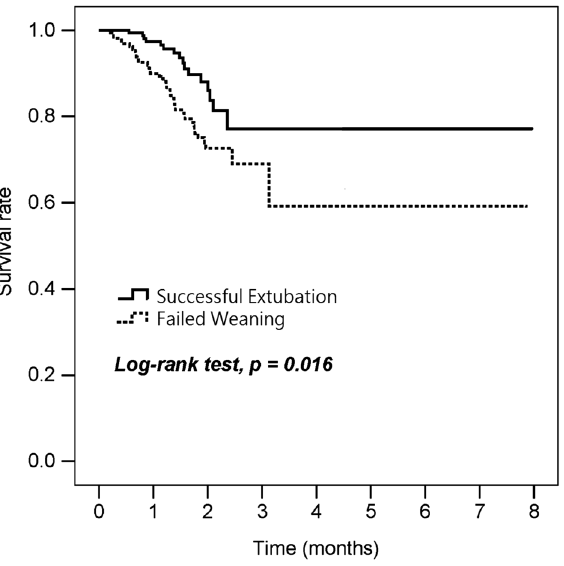
Figure 2. Survival curves for patients of successful extubation and patients of failed